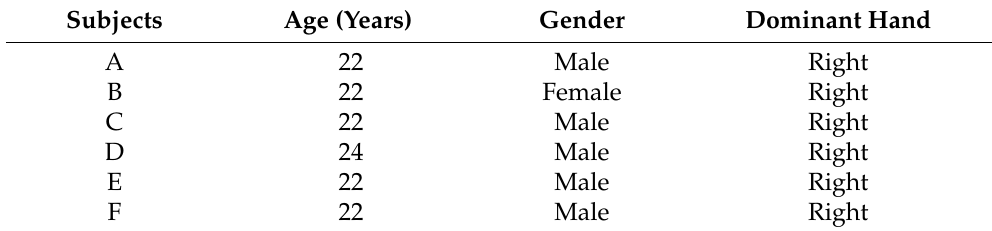
Table 1. Information on